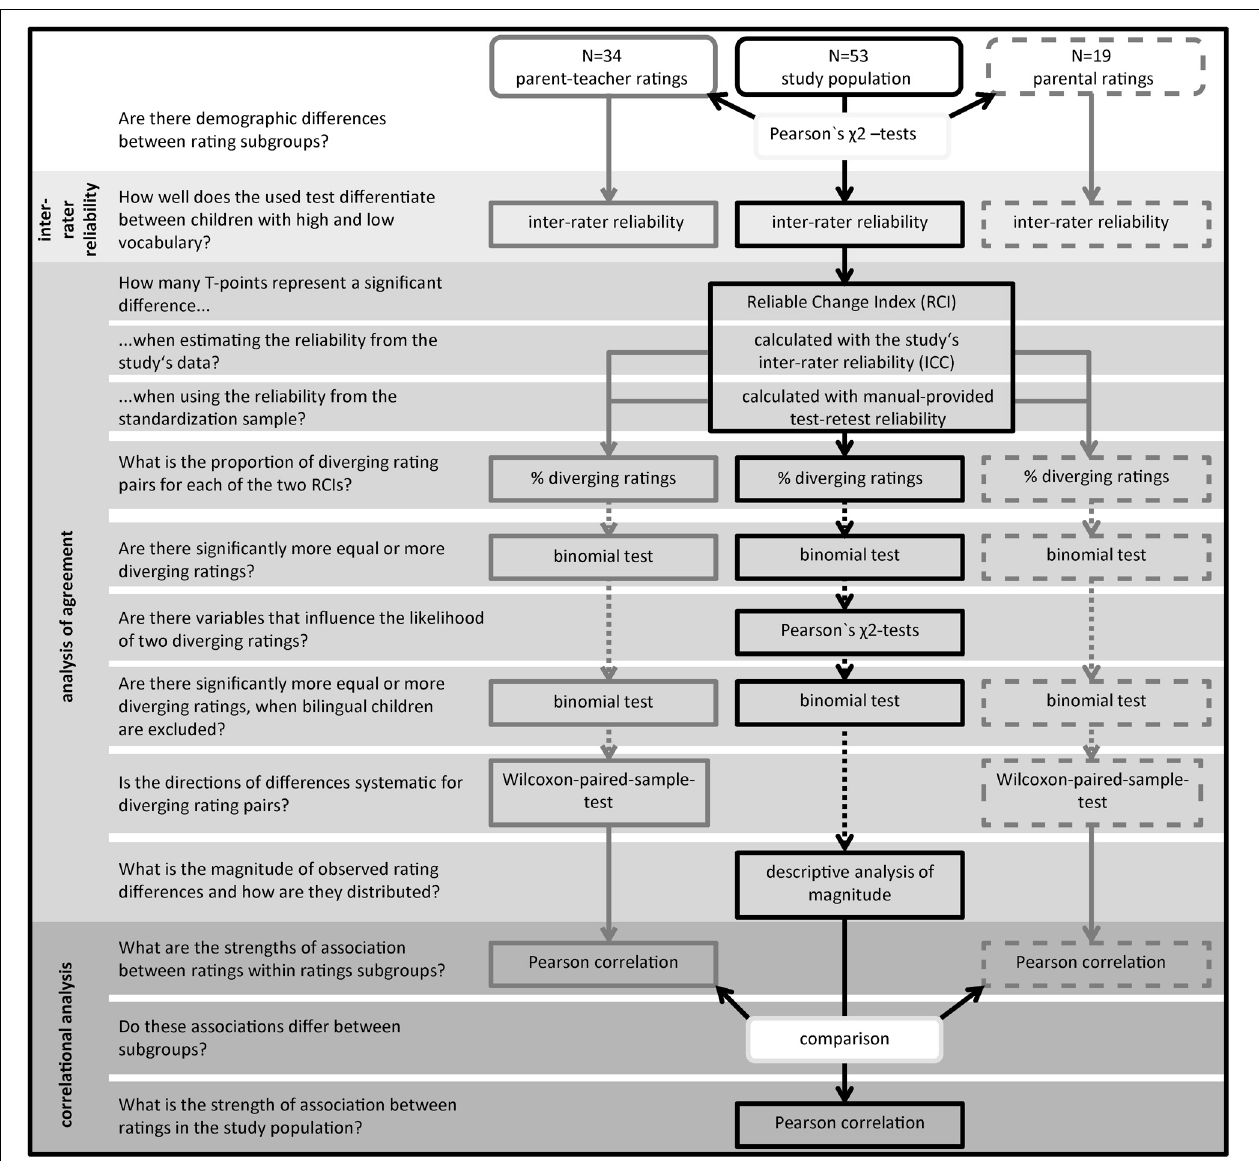
FIGURE 1 | Analysis procedure. A total of 53 rating pairs was included in the analysis and divided in two rating subgroups (represented by round boxes in the upper line). On the left side of the figure the purpose of the applied statistical analysis is provided framed as research questions. The next column shows the analyses conducted within the parent–teacher rating subgroup ( n = 34), in the right column the respective analyses for the mother–father